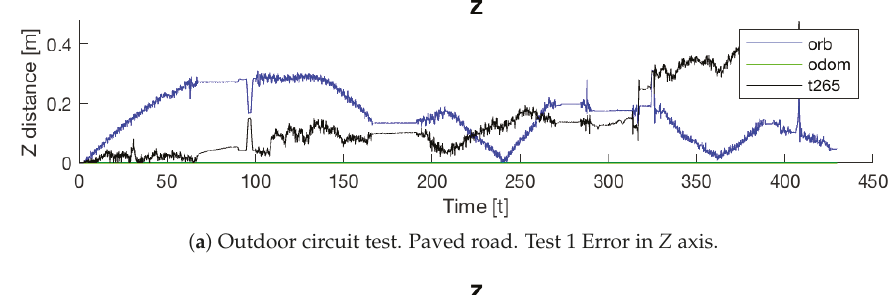
Figure 33. Outdoor circuit test on paved road.